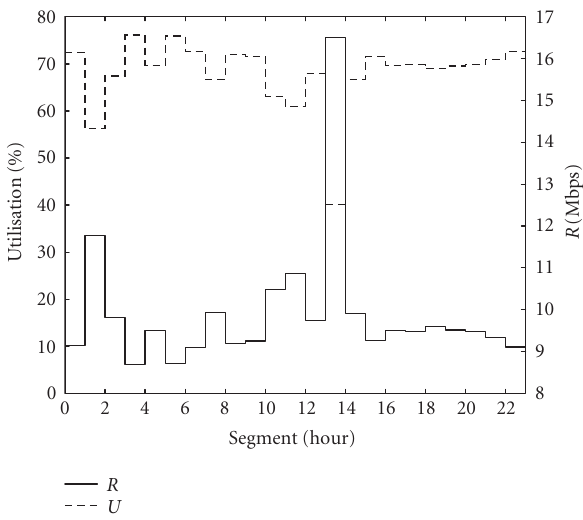
Figure 9: Dynamic short-term provisioning for MAWI tra ffi c.